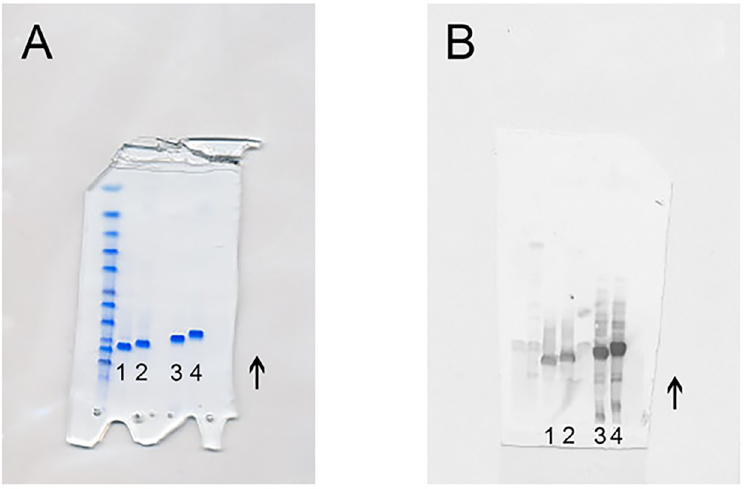
Fig 1. SDS-PAGE and Western blot with rabbit anti-plasminogen antibodies. (A) SDS-PAGE showed the presence of four 4 proteins. (B) Western blot with rabbit anti-plasminogen antibodies showing strong binding for the unreduced plasminogen variants and weak binding for the reduced plasminogen variants. 1, reduced glutamic acid plasminogen; 2, reduced lysine-plasminogen; 3, unreduced glutamic acid plasminogen (88 kDa); 4, unreduced lysine- plasminogen (83 kDa). The arrows show the direction of movement of the